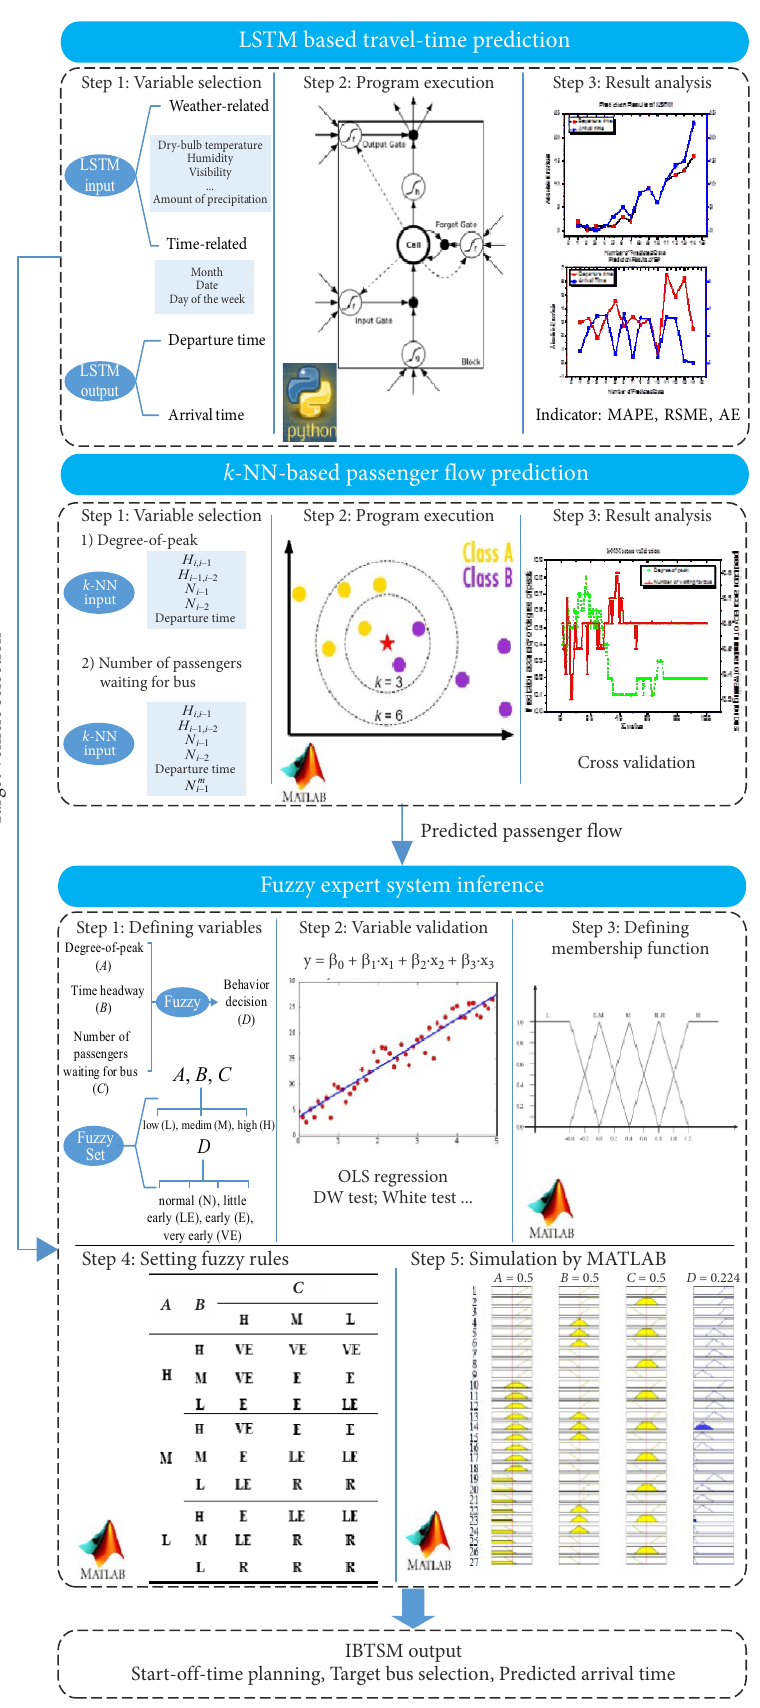
Figure 4. Implementation process of the